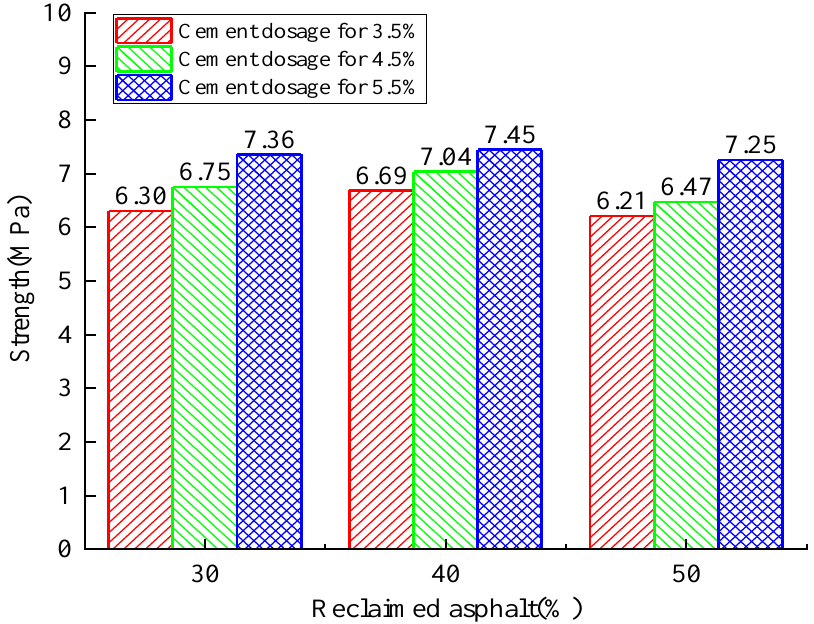
Figure 9. Analysis of the 28-day axial compressive-strength test with variation of cement dosage and RAP.